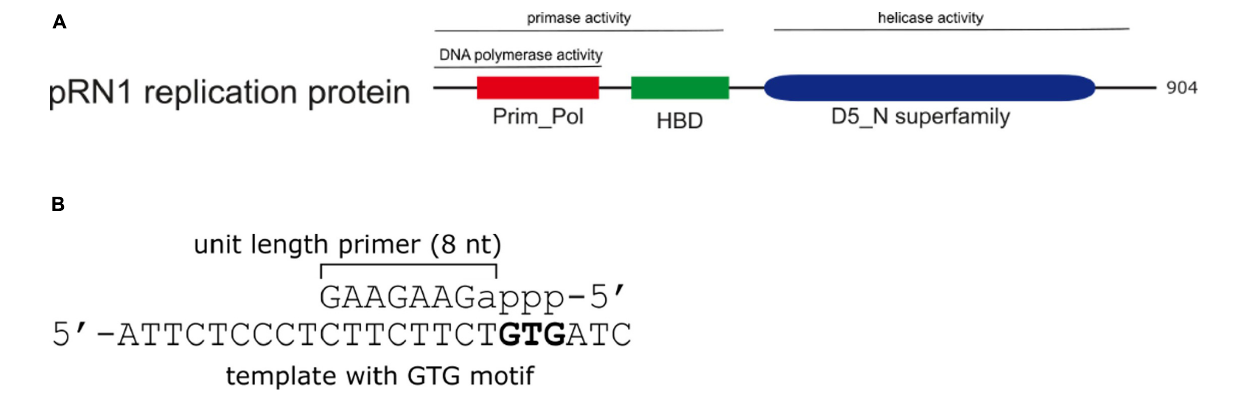
Frontiers in Microbiology |